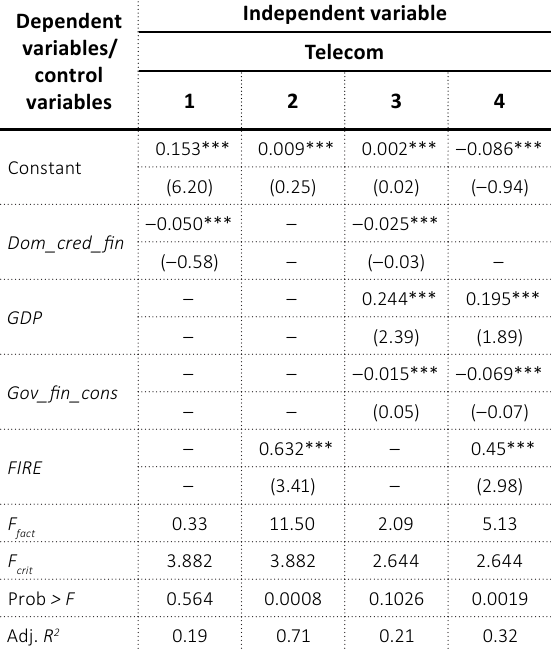
Table 3. Results of identifying the